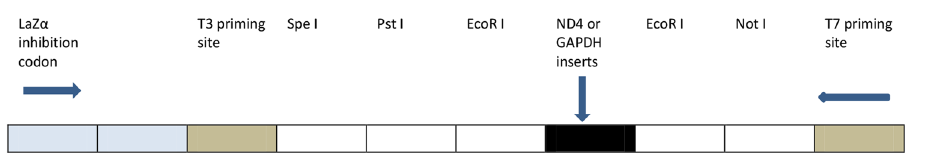
Figure 5. Schematic diagram of single-insert plasmid pCR TM 4-TOPO (3956 nucleotides). The diagram shows site into which specific fragments of chicken ND4 or GAPDH genes were inserted. The fragments in the study were flanked by restriction and priming